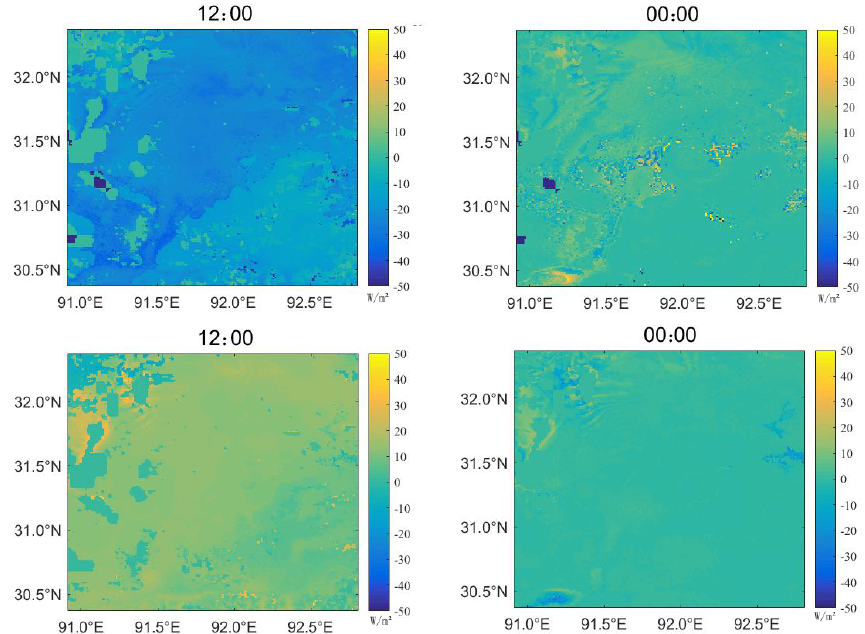
Figure 10. The difference of the control and sensitivity experiments simulated regional sensible heat flux at (a) 12:00LT and (b) 00:00LT and latent heat flux at (c) 12:00LT and (d)